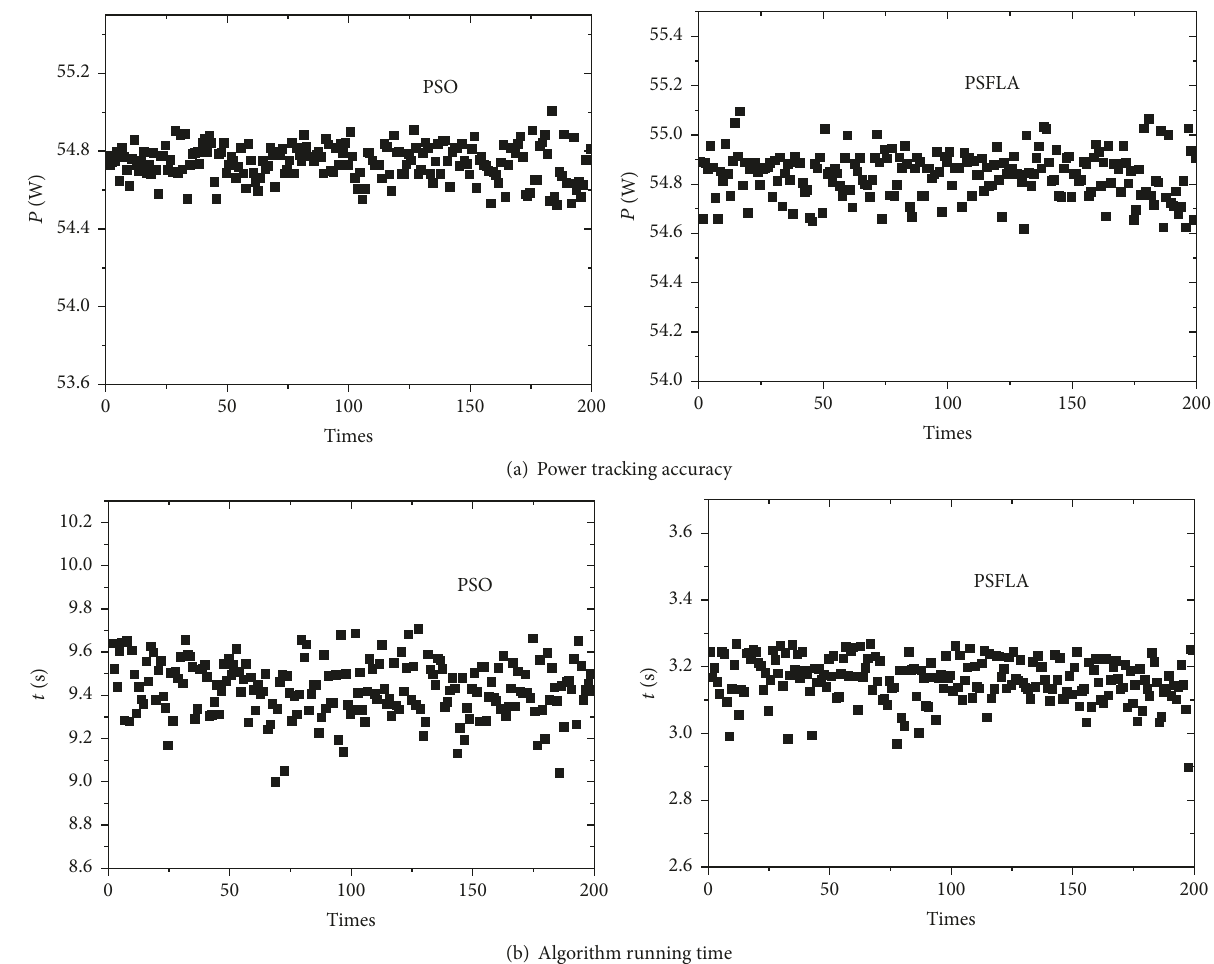
Figure 16: Experimental results for test